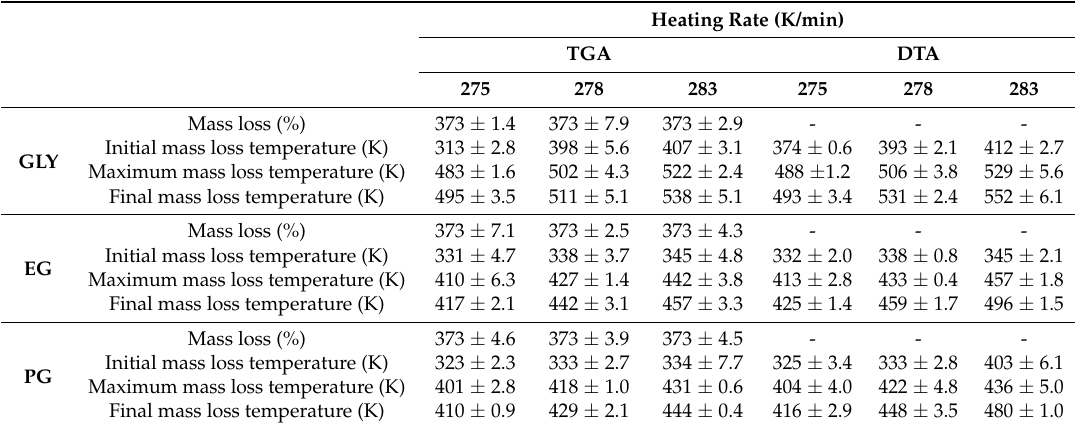
Table 1. Boiling temperature range of the polyols, determined by simultaneous TGA-DTA at different heating